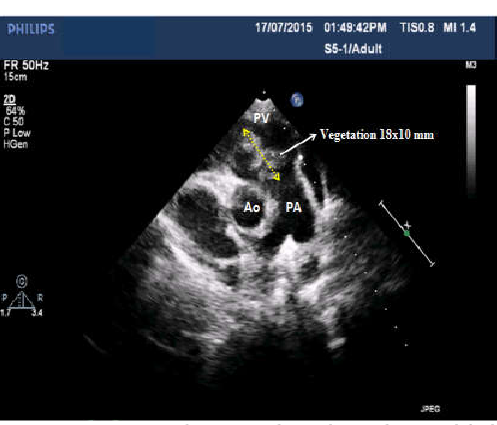
Figure 1. 2D transthoracic echocardiography, modified parasternal short axis view at the level of aortic valve shows vegetations (with the largest size of 18×10 mm) over the pulmonary valve prolapsing into the pulmonary artery (Ao: aortic valve, PA: pulmonary artery) the septal leaflet of the tricuspid valve, which was diography (Figure 2).